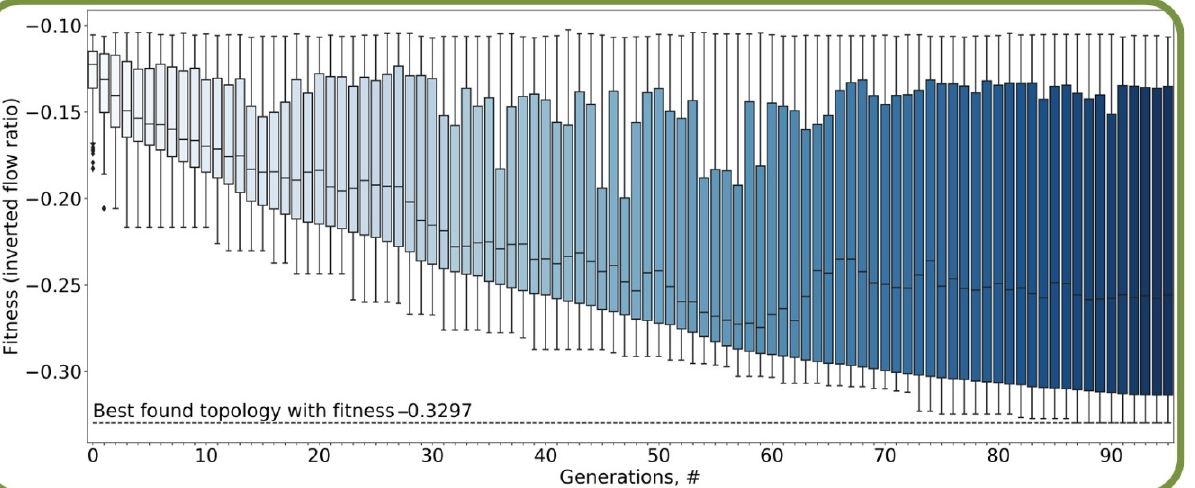
Figure 3. The convergence of the fitness function values (the function that is used to estimate how close a given design solution is to the specified aim) during the evolutionary optimization of cell traps for the 100 generations (#, iterations of evolution). The boxplots represent the diversity of the solutions in each population: the centerline of each box represents the median of the fitness distribution in each population, the boundaries of the box—25 and 75 percentiles of the same distribution, and the additional lines, represent the minimum and maximal values of fitness. The solution with the best fitness in all populations is highlighted with the dashed line. It can be seen that the quality of solutions improved steadily during the optimization. The shade of the boxplots’ color depends on the number of a generation.